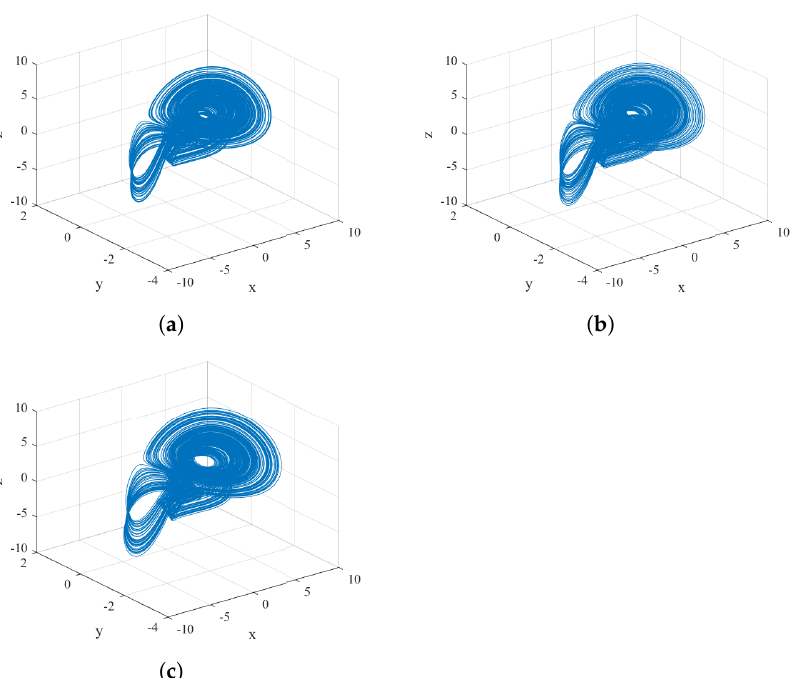
Figure 3. Phase diagrams of the optimized fractional-order chaotic system (2) as presented in Table 1: ( a ) DE-optimized; ( b ) PSO-optimized; ( c )